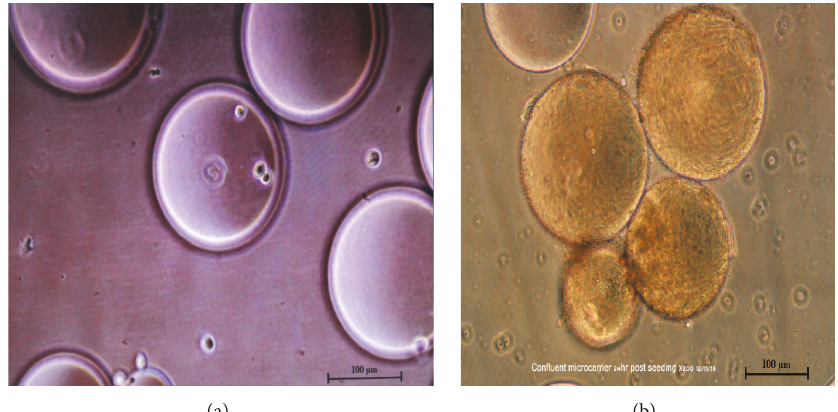
Figure 1: BGM-70 cells attaching to cytodex microcarrier 1 in a bioreactor. (a) BGM-70 cells attaching to cytodex at 6 hours ps. (b) Confluent cells on cytodex at 24 hours ps. Bar=100 𝜇